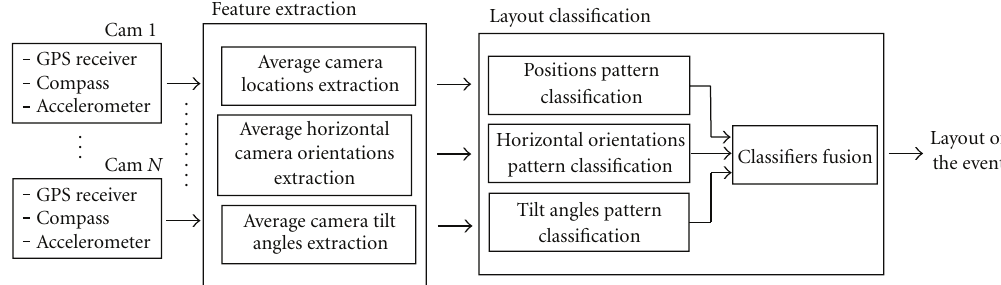
Figure 5: Processing steps for classifying the layout of an